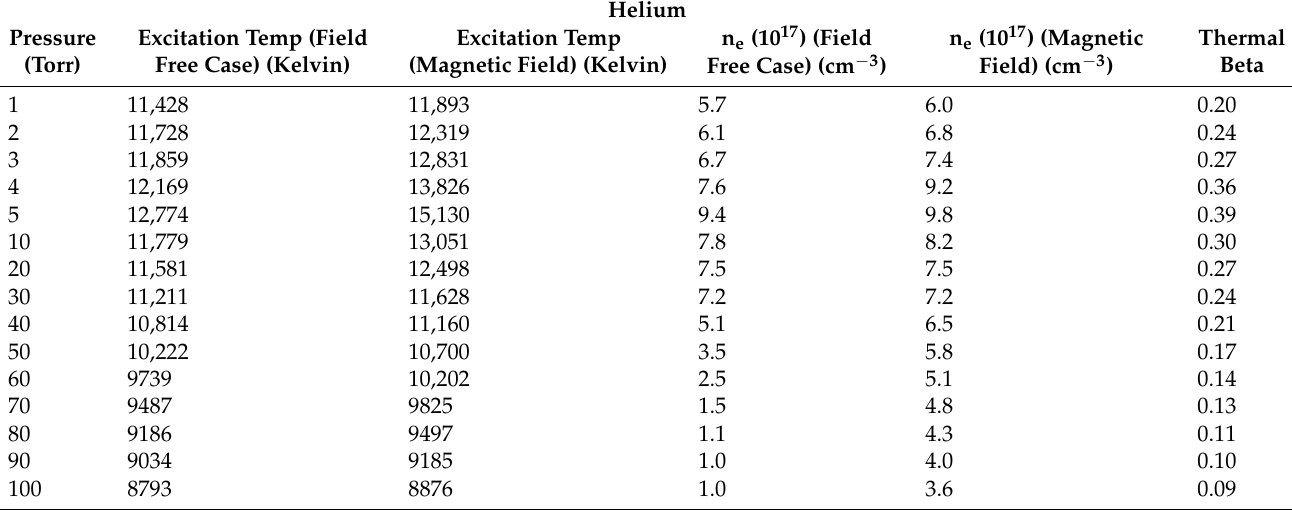
Table 4. Evaluated T exc , n e , and β t values for laser-irradiated Mg plasma at various He pressures in the presence and absence of